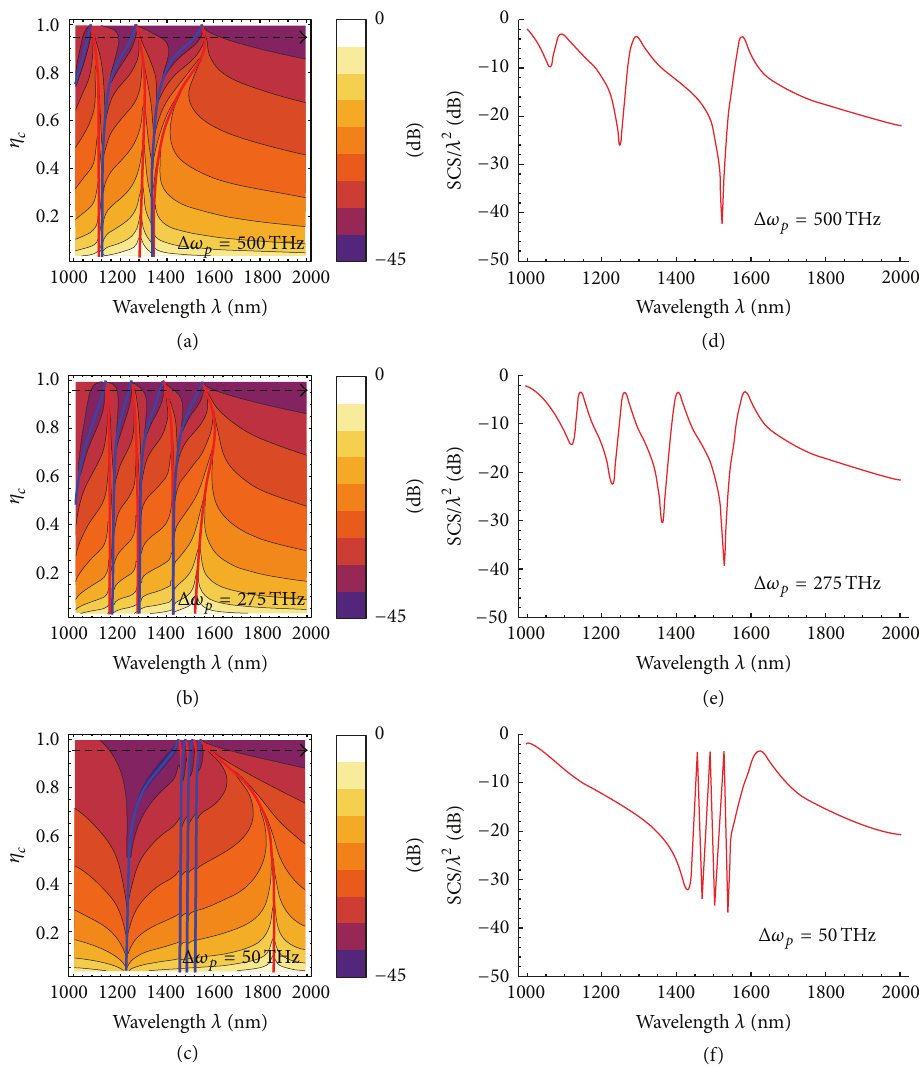
Figure 5: (a)–(c) Contour plots of the total SCS (normalized to the maximum value) as a function of wavelength and aspect ratio 𝜂 𝑐 . (d)–(f) normalized SCS /𝜆 2 versus wavelength, for different plasma frequencies in the four plasmonic layers of the geometry of Figure 1(b): (a), (d) = 500 THz, (b), (e) Δ𝜔 = 275 THz, and (c), (f) Δ𝜔 = 50 THz. The aspect ratio is fixed in these cases to 𝜂 Δ𝜔 𝑝 𝑝 𝑝 dashed arrow in panels (a)–(c)). Cloaking (blue lines) and resonant scattering (red lines) quasi-static conditions are also shown in the contour plots